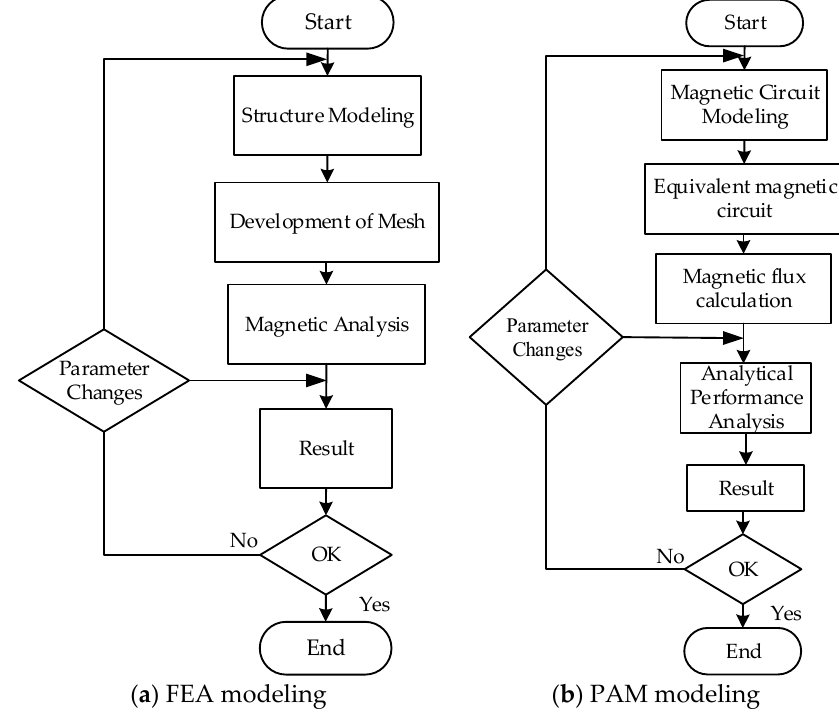
Figure 2. Flowchart of DSSR-PMG for FEA modeling and PAM modeling.